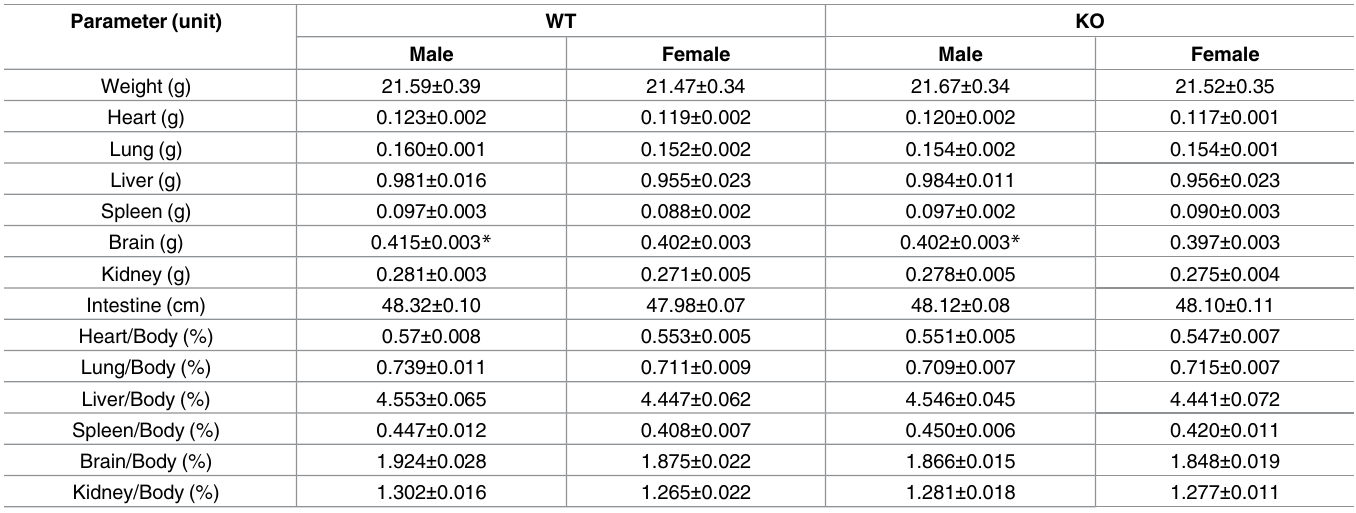
Table 7. Organ weights and ratios in the control and model